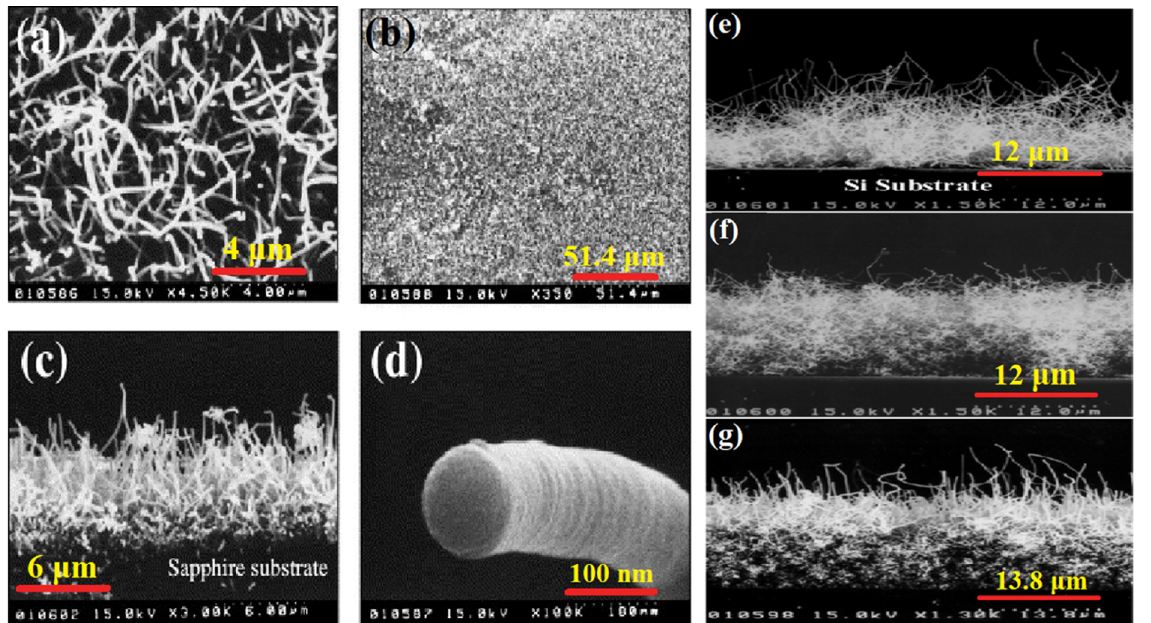
Figure 7. The four images ( a – d ) show various views in the SEM imaging of the sample with the nanowires visible [129]. “Reprinted with permission from Ref. [129]. Copyright (2004), Elsevier”. ( e – g ) show the three images of samples with different deposition times of 3, 4 and 5 min [130]. “Reprinted with permission from Ref. [130]. Copyright (2006), Taylor and Francis Online”.